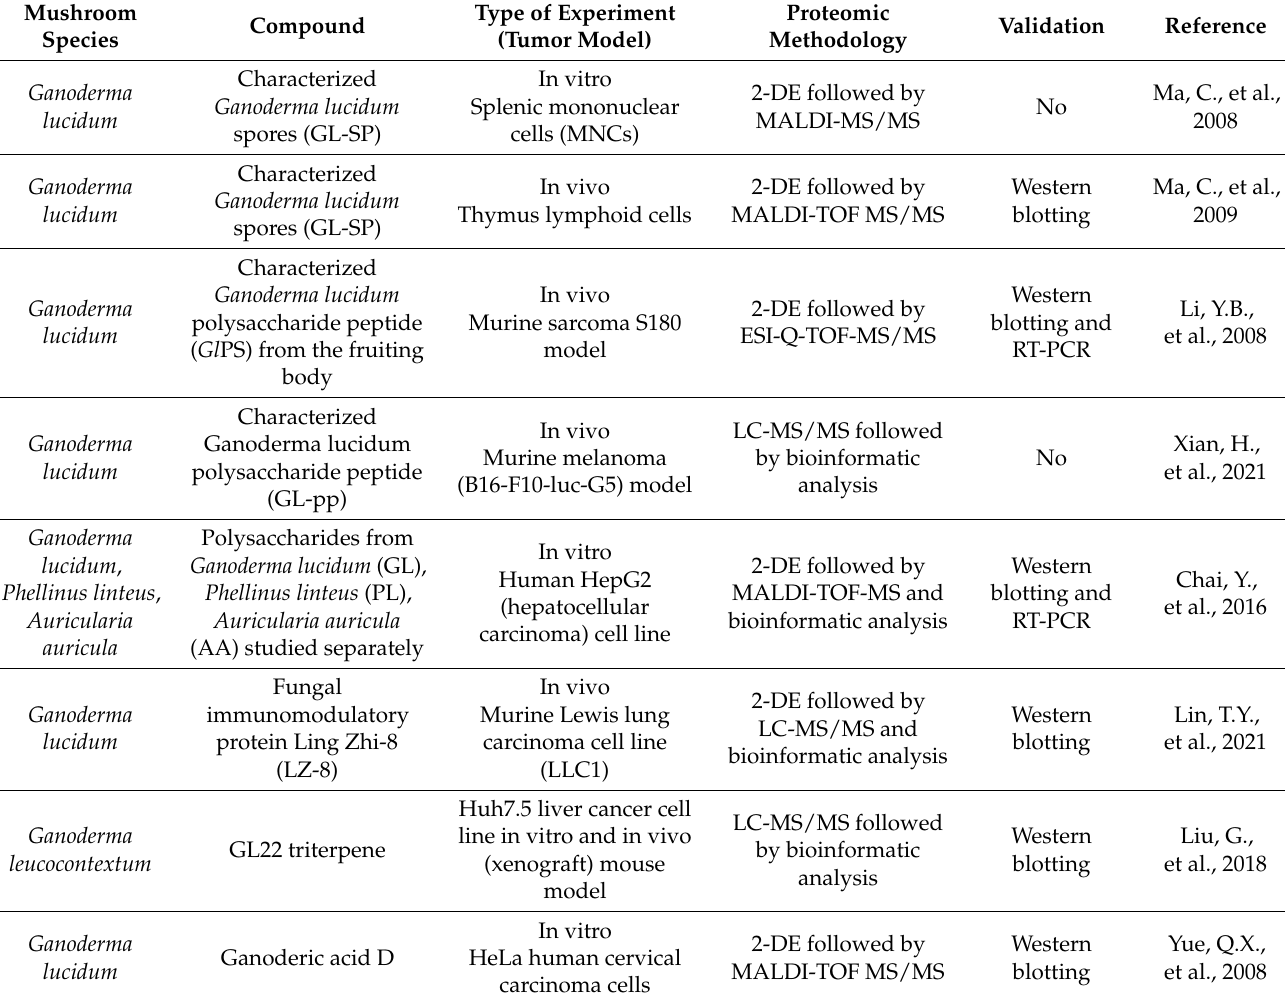
Table 1. Primary research included in this review and its experimental